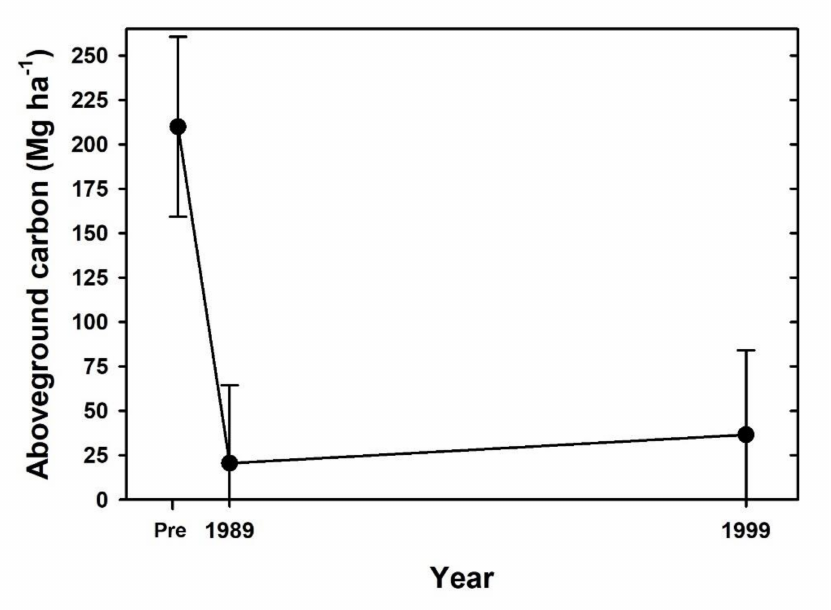
Figure 2. Aboveground live tree carbon from pre-disturbance, immediately after disturbance, and ten years after disturbance. Error bars are one standard deviation; pre-disturbance sampling from six 20 m × 20 m plots; 1989 and 1999 sampling from 55, 12.57 m 2